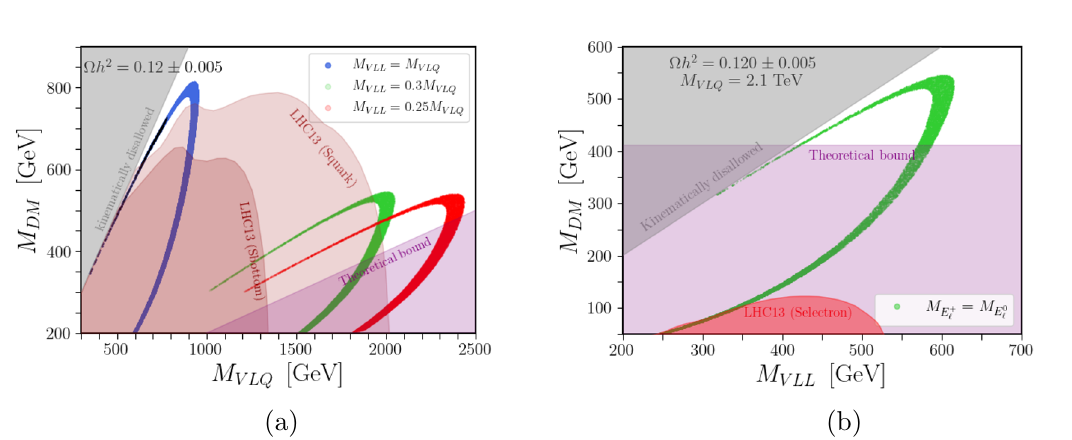
Figure 7 . Allowed regions in the mass of dark matter M DM and mass of vector-like fermion M V LQ ( M V LL ) plane that satisfy relic abundance requirement. The T -even h 0 and T -odd H 0 scalar masses are taken much heavier than the mass of vector-like fermions here, so that only t -channel process as shown in figure 5 (a) contributes. The gray and purple shaded regions are respectively from kinematically disallowed ( M DM > M V LQ ) region and theoretical bound ( M V LQ > 5 M DM ). In the left panel (blue, green, red) shades respectively represents allowed parameter space that satisfies the relic abundance for the choice M V LL /M V LQ = (1 , 0 . 3 , 0 . 25) . Dark (light) brown corresponds to the exclusion region from pp → jj ( bb ) + /E obtained by recasting the supersymmetric squark T (sbottom) searches. The black segment along the abundance curve is excluded from direct detection constraints [49]. In the right panel the green band corresponds to the allowed parameter space that satisfies the relic abundance for a fixed VLQ mass 2 . 1 TeV. The red band is the exclusion region from pp → l + l − + /E signature obtained by recasting supersymmetric slepton searches at the T